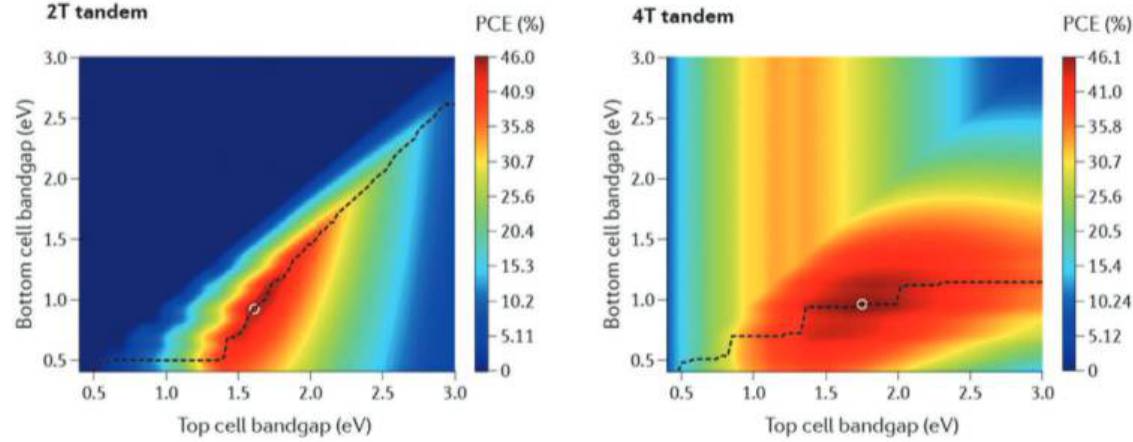
Figure 3. The schematic diagram of simulated optimized bandgap [28].